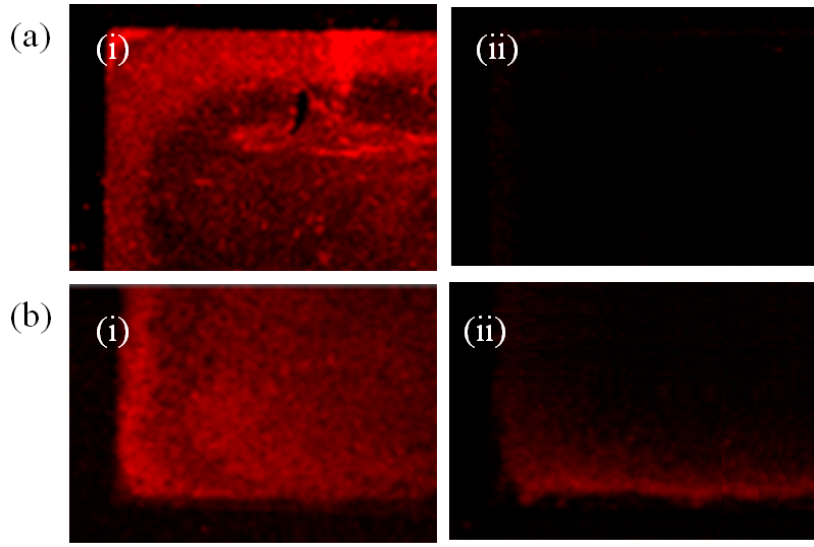
Figure 6. Fluorescence signal measurements with respect to different aptamer lengths ( a ) 15mer ( b ) 21mer of thrombin specific aptamers ( i ) just after thrombin solution was added ( ii ) after 15 min incubation and rinse.